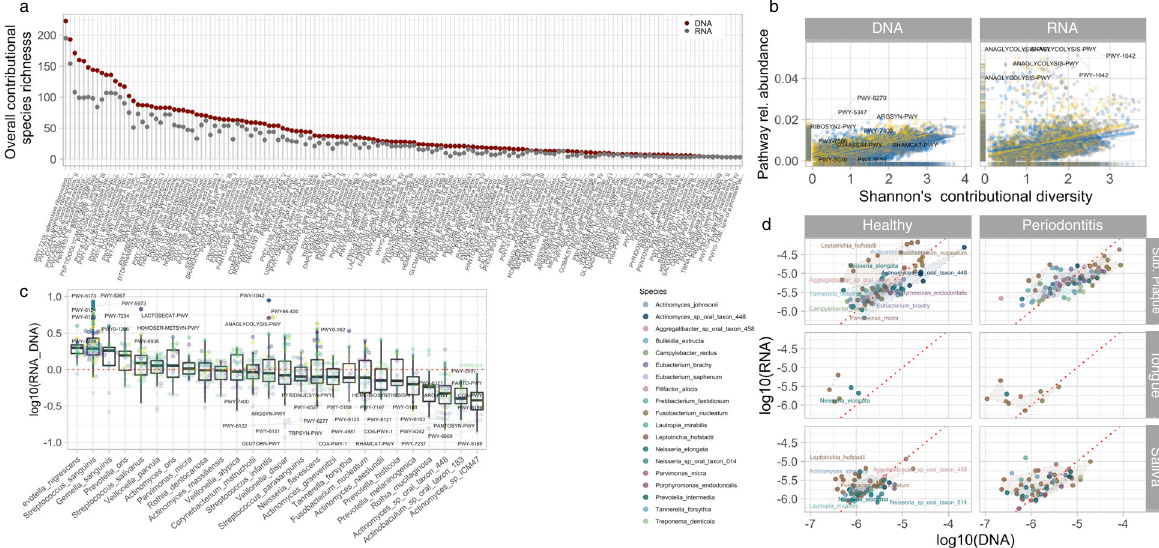
Fig. 2 Pathway-level contributional diversity and species transcriptomal activity of oral microbiome. a Overall contributional species richness represented in metagenomic (DNA) and metatranscriptomic (RNA) pathway pro fi les determined across all paired samples. Only pathways expressed (RNA) by at least two species were plotted. b Relationship between pathway relative abundance and contributional species diversity (Shannon diversity index) in metagenomic (DNA) and metatranscriptomic (RNA). Each point represents a pathway and depicts its sample abundance as well species diversity (Shannon diversity index) potentially contributing (DNA) or actively contributing (RNA). We found that pathway abundance and contributional species diversity quite correlate in metagenomes (DNA) while some pathways clearly exhibited overexpression (RNA). Some highly expressed pathways which are not necessarily expressed by highly diverse communities. Pathway code was display for pathway with Abundance > 0.045 or shannons_div < 0.03. c Differences in per-pathway metagenomic (DNA) versus metatranscriptomic (RNA) contributions of top bacterial species as described in Fig. 1c. Each point represents the overall species transcriptional activity averaged within samples from different sites from the same Subject and across patients. Some species exhibited an overall tendency for overtranscription or undertranscription, whereas others displayed pathway-speci fi c activity patterns. Boxplots display fi rst quartile, median, and third quartile and whiskers represent 1.5 times the interquartile range from the fi rst and third quartiles. d Pathway-level transcriptomal activity of species found to be differentially abundant between healthy and patients with periodontitis (see Supplementary Fig. 1A). The activity of each species is average within sample (average of pathways detected within paired metagenomes and